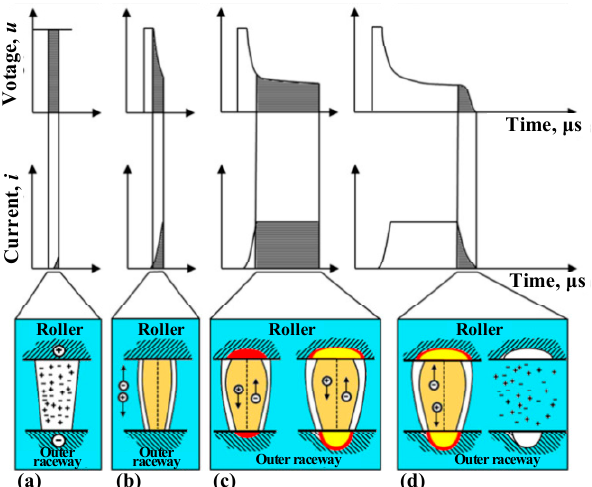
Figure 2. The process of discharge between the bearing roller and the raceway (a) ignition; (b) for- mation; (c) discharge; (d) ejection